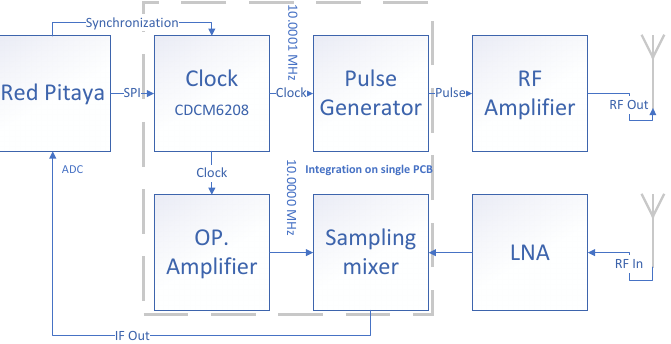
Figure 1. Block diagram of proposed radar. Blocks inside the dashed line are integrated on a single PCB (printed circuit